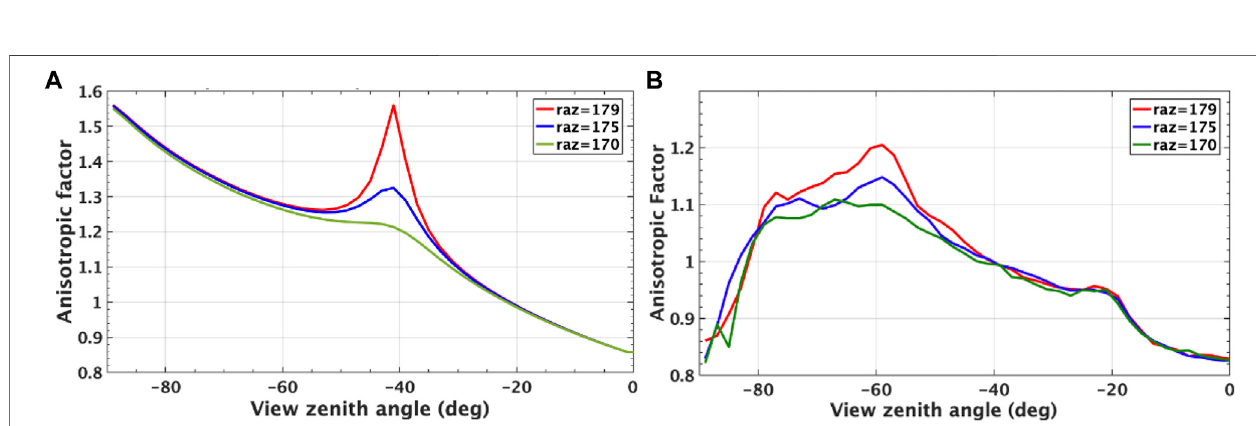
Frontiers in Remote Sensing |